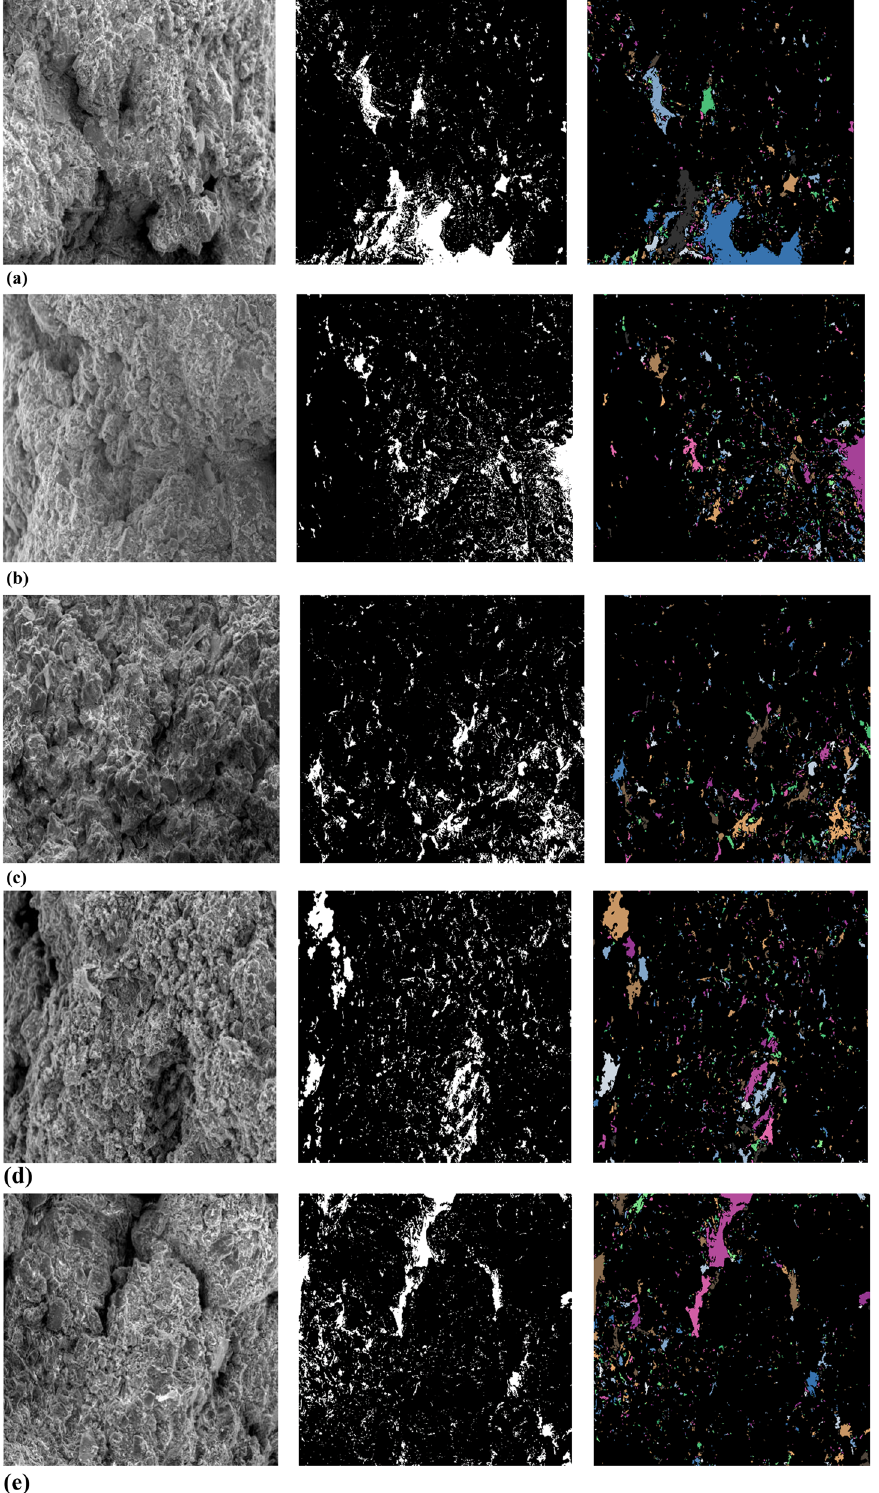
Figure 21: SEM images of specimens with di ff erent modi fi ed materials: ( a ) binarization graphics and particle recognition results of pure yellow mud specimens; ( b ) binary graphics and particle recognition results of specimens with straw; ( c ) binary graphics and particle recognition results of specimens with starch; ( d ) binary graphics and particle recognition results of specimens with cement; and ( e ) binary graphics and particle recognition results of specimens with epoxy